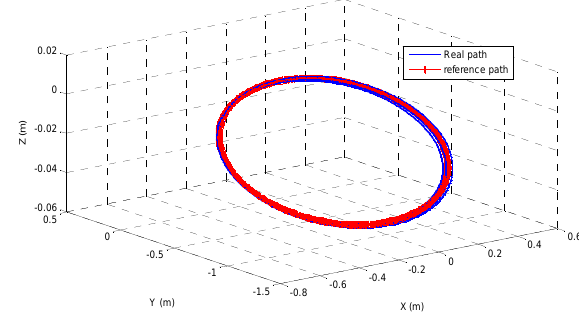
Fig.8. Comparison of real path and reference path on 3degree slope